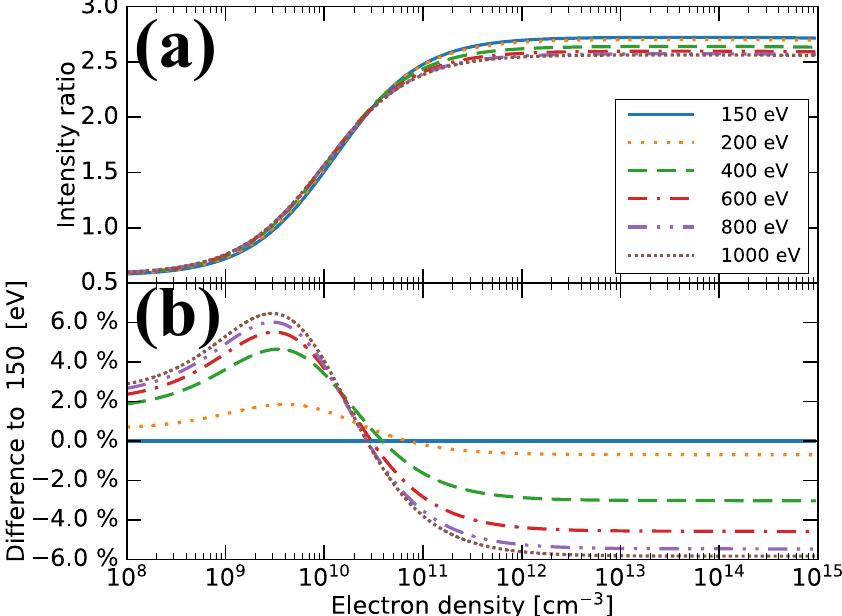
Figure 6. ( a ) Electron density dependence of Fe XIV 264.785 Å/274.203 Å intensity ratio for various temperatures for IoEx1p1 model. ( b ) Difference in intensity ratio to relative case of 150 eV at each